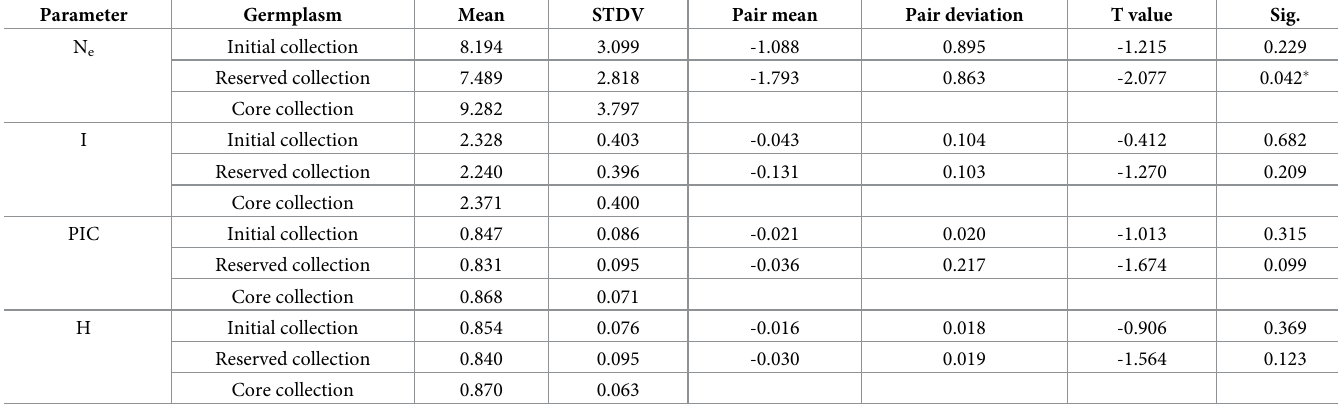
Table 1. T-test results of the optimal core collection and initial collection, core collection and reserved collection.